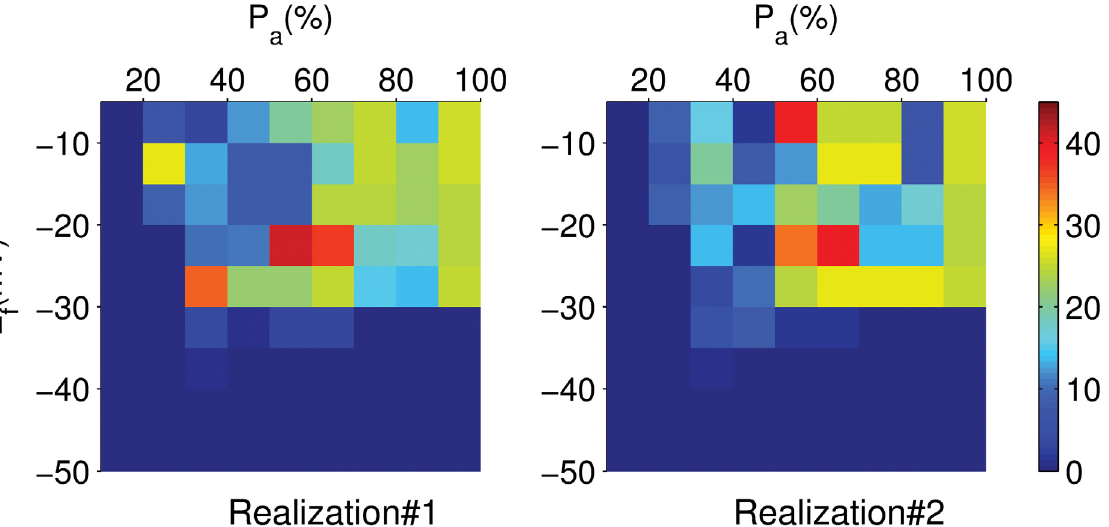
Fig 14. Number of PVC triggerings in the E f − P a plane in a 1D cable. Pseudocolor plots showing the different numbers N of PVC triggerings, indicated by different colors (see the colorbar), in the E f − P a plane for two different realizations of fibroblast distribution in a 1D cable with its EAD segment attached to fibroblasts randomly. P a is the percentage of fibroblasts attached to the EAD segment. These plots illustrate the sensitive dependence of the number of PVCs on the distribution of